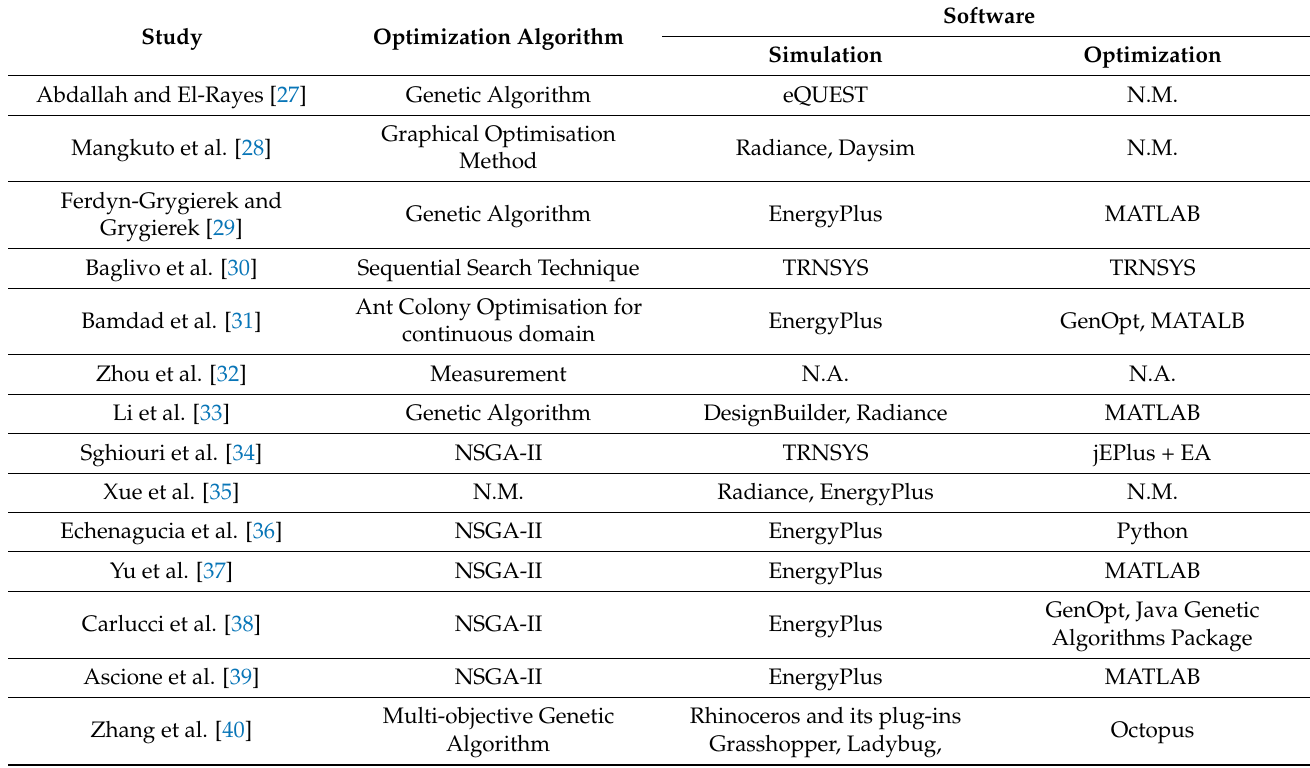
Table 7. The optimization algorithms and the software which have been used in the core